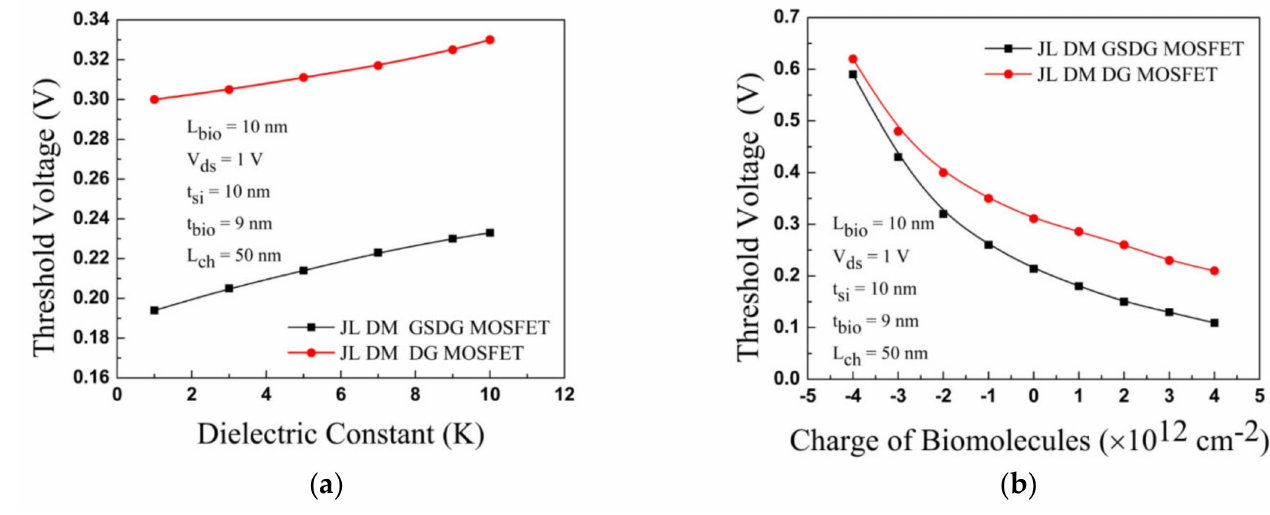
Figure 10. Variation of threshold voltage for JL-DM-DG-MOSFET and JL-DM-GSDG-MOSFET: ( a ) neutral biomolecules; ( b ) charged